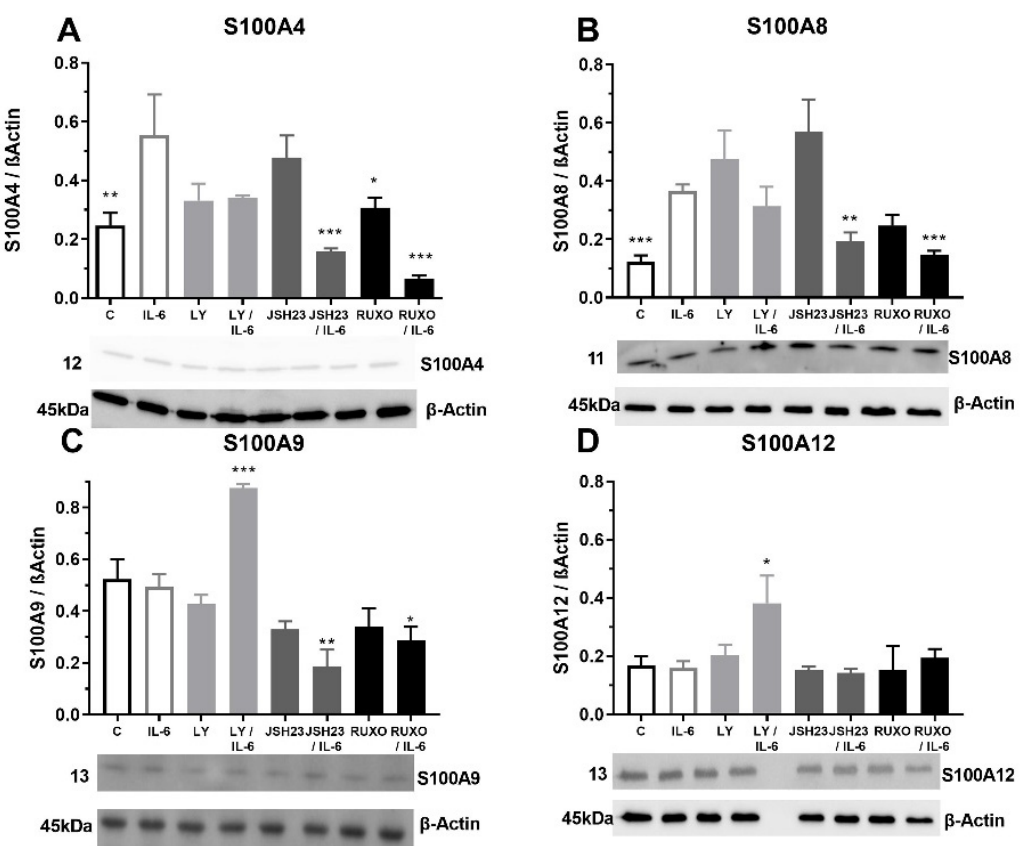
Figure 4. Proinflammatory IL-6 increase of S100As protein expression in mononuclear cells (MNCs) of peripheral blood of chronic lymphocytic leukemia (CLL). MNCs of CLL patients were treated 1 h by 20 µg/mL IL-6 in combination with and without 0.6 nM Ruxolitinib, 5 nM LY294002 and 0.75 nM NF- κ B inhibitor JSH23 and levels of ( A ) S100A4, ( B ) S100A8, ( C ) S100A9, and ( D ) S100A12 were defined. Data results are presented as mean ± SD ( n = 5). * p < 0.05, ** p < 0.01, *** p < 0.001 versus IL-6 treated MNC.